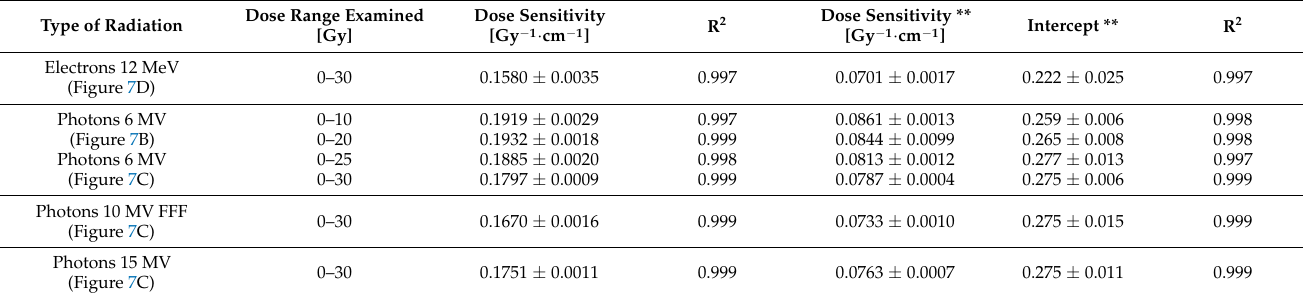
Table 2. Basic dose response features of Fricke-XO-Pluronic F-127 containing 0.2 M NaCl. Dynamic dose response is up to 50 Gy and dose threshold is lower than 0.5 Gy; 0.5 Gy was the lowest dose applied in this study. Dose sensitivity is understood to be the slope of the linear regression. Dose sensitivity ** and Intercept ** are calculated from Absorbance (585 nm) vs. dose relations (not shown in this work) for 1 cm pathlength. The Dose sensitivity ** multiplied by the factor of 2.303 gives the optical attenuation coefficient according to the approach in